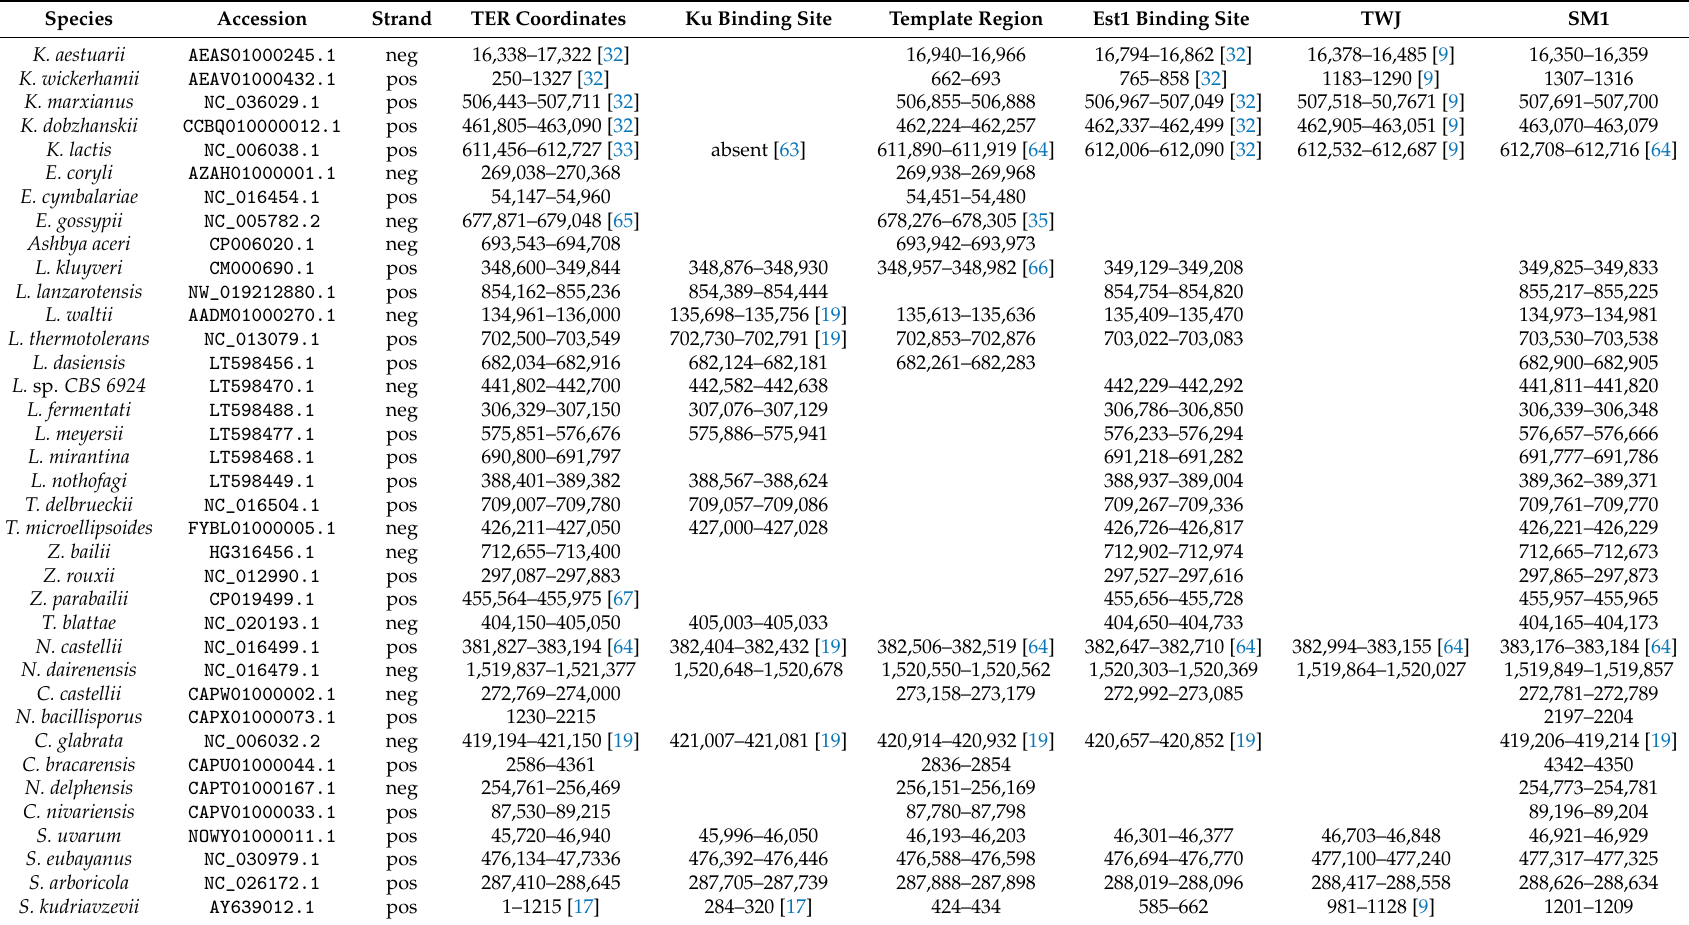
Table 1. Overview of conserved TER substructures in Saccharomycetacea, as identified by the combined synteny/covariance model pipeline. The 3 (cid:48) end is defined as 10 nt downstream of the SM binding site. The 5 (cid:48) end is approximate. Citations refer to publication in which the sequence and/or the coordinates of respective features are reported explicitly. These annotations form the basis of Figure